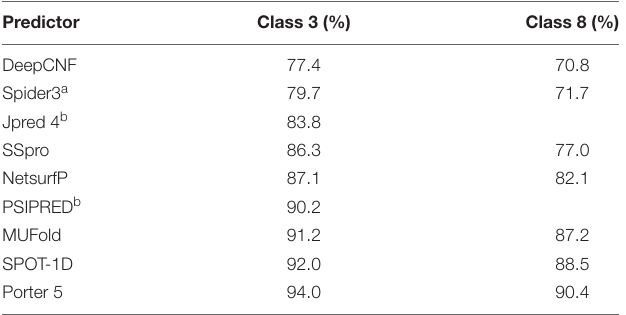
TABLE 2 | Percentage of secondary structure classifications matching a consensus classification.